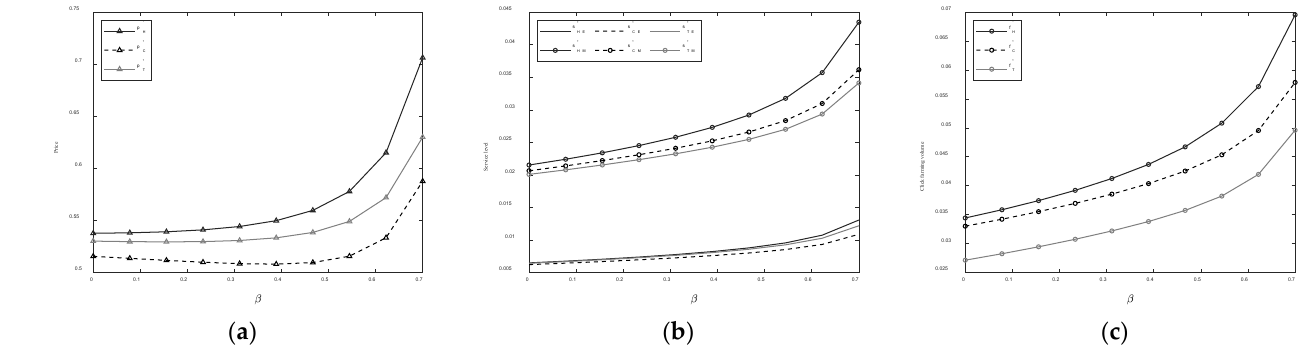
Figure 8. Influence of consumer dissatisfaction on price ( a ), service level ( b ) and click farming volume ( c ) respectively.